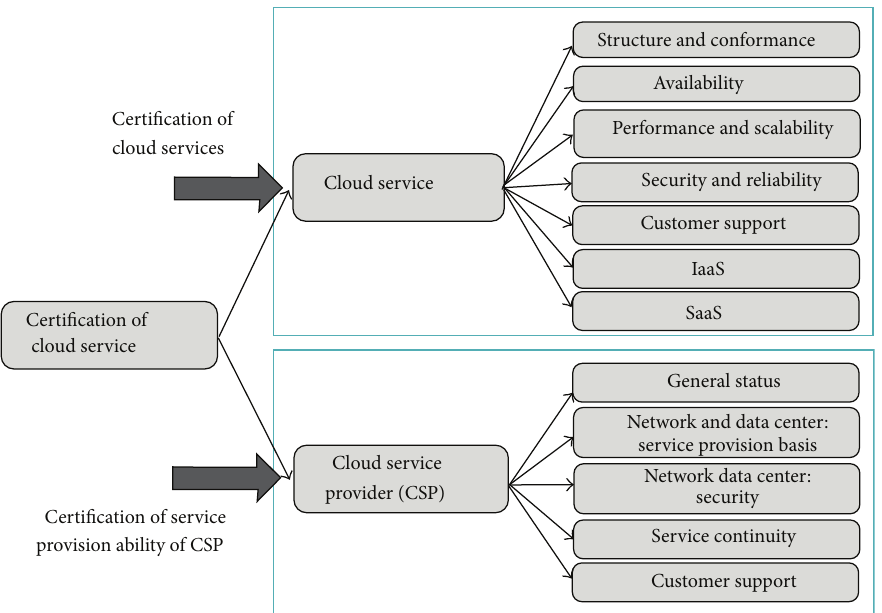
Figure 2: Certification scope and evaluation criteria for cloud